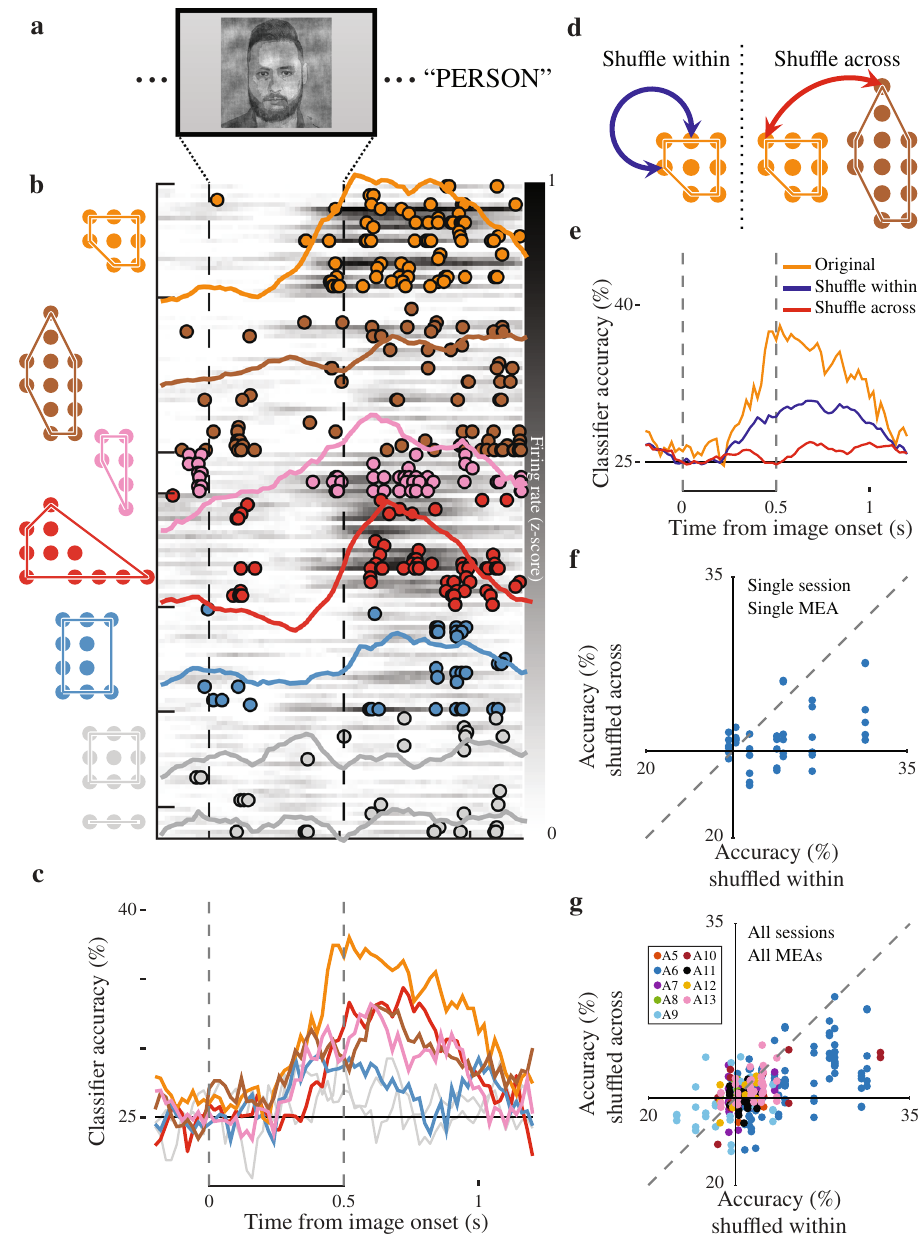
Fig. 4 | Differential category coding by individual modules. a Category recog- nition task. Participants are shown images on a laptop screen and asked to cate- gorize them as people, places, animals, or objects. During the 'PERSON' trials participants are shown pictures of famous people; due to licensing requirements we show a representative image that is not part of the stimulus set. b Response properties of individual modules. For an individual 'PERSON' trial the spike times are colored according tothe modulethatthe spike came from (left).The grayscale background represents the trial-averaged fi ring rate for each individual unit, and the colored lines show the average fi ring rate for each module. Neuronal spiking appears to cluster in time according to module membership. This was true for individual trials as well as on average across all 'PERSON' trials. c Coding of image category by individual modules. Each line represents the time-course of classi fi - cationwhenusingdatafromonlythatmodule.Somemodulescontaininformation